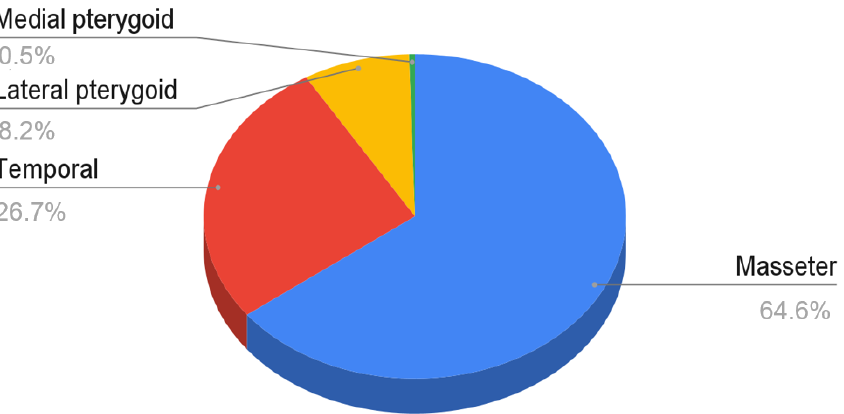
Figure 2. The number of interventions in the form of needling of each of the masticatory muscles in relation to the total number of patients included in the analyzed material.